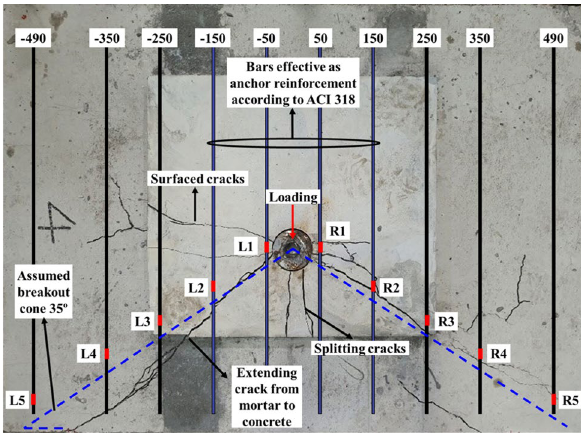
Figure 15. Locations of stirrup and strain gauge